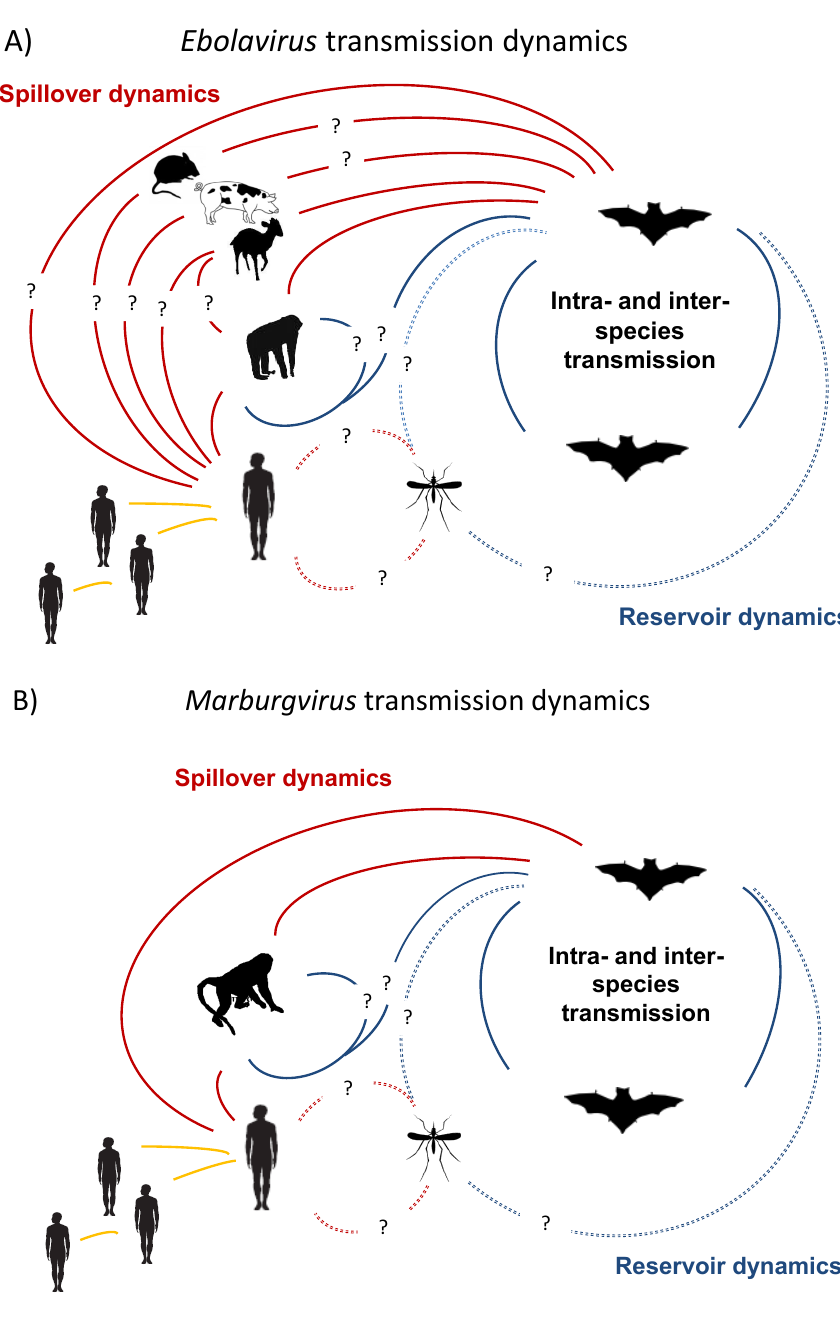
Figure 1. ( A ) The multiple transmission pathways are shown for Ebolavirus genera viruses. The role of vectors is unlikely, but not known (dashed line). Those pathways with epidemiological uncertainty are shown with question marks. Potential reservoir dynamics are shown in blue, spillover epidemics in small mammals (Africa), pigs (Reston ebolavirus only), duikers (Africa), primates and humans shown in red and ongoing human transmission in orange; ( B ) The multiple transmission pathways are shown for Marburgvirus genera viruses. The role of vectors is unlikely, but not known (dashed line). Those with epidemiological uncertainty are shown with question marks. Potential reservoir dynamics are shown in blue, spillover epidemics in primates and humans shown in red and ongoing human transmission in